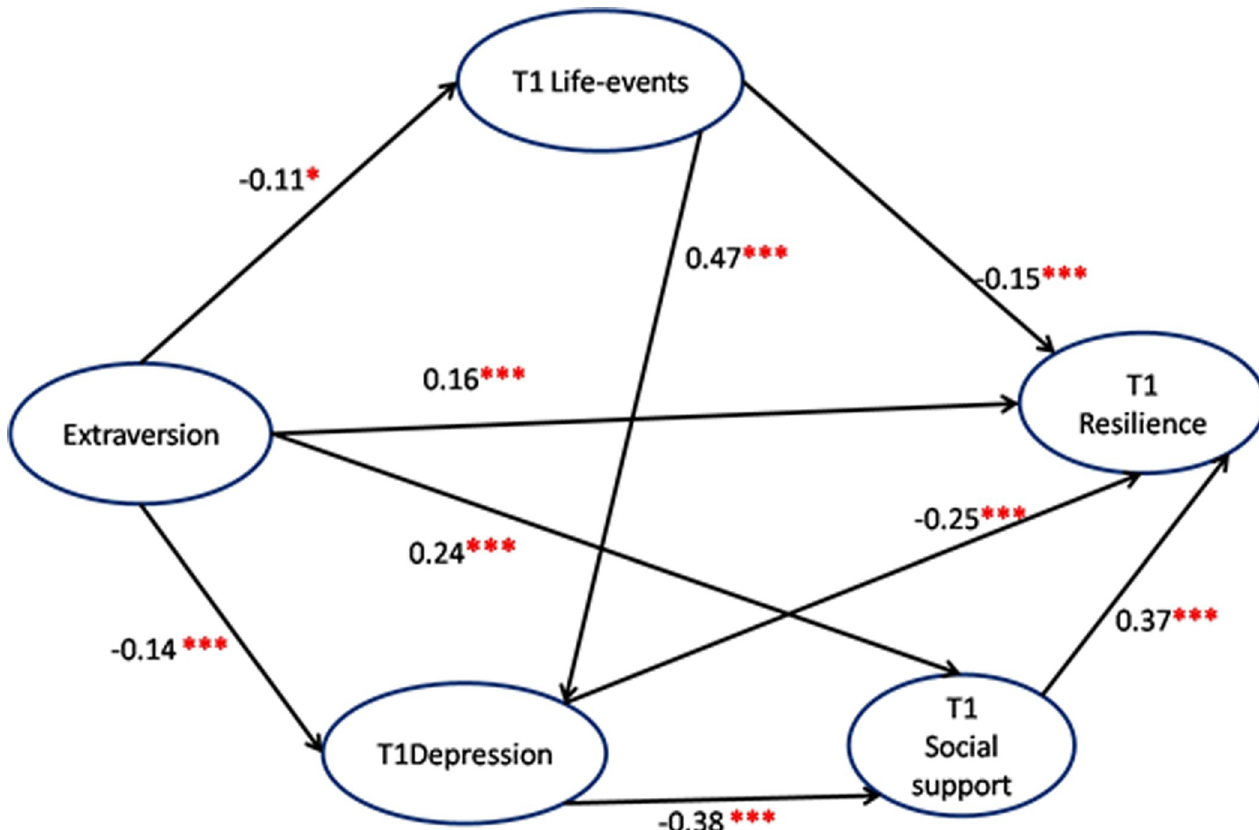
Fig 1. Structural equation model for T1 resilience. Note: ��� P < 0.001. �� P < 0.01. T1 = Year 2016. Key information of model: CFI = 0.999, IFI = 0.999, NFI = 0.997, RFI = 0.966, RMSEA = 0.04, CMIN/DF =